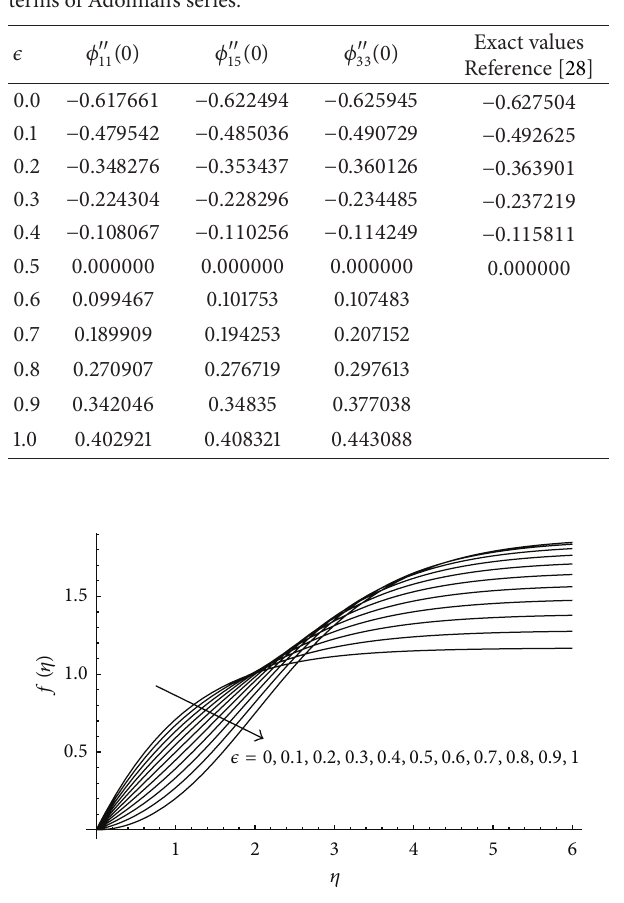
Figure 3: The stream function for the class of the Falkner-Skan problematdifferentvaluesof 𝜖 using15termsofthecurrentmethod.